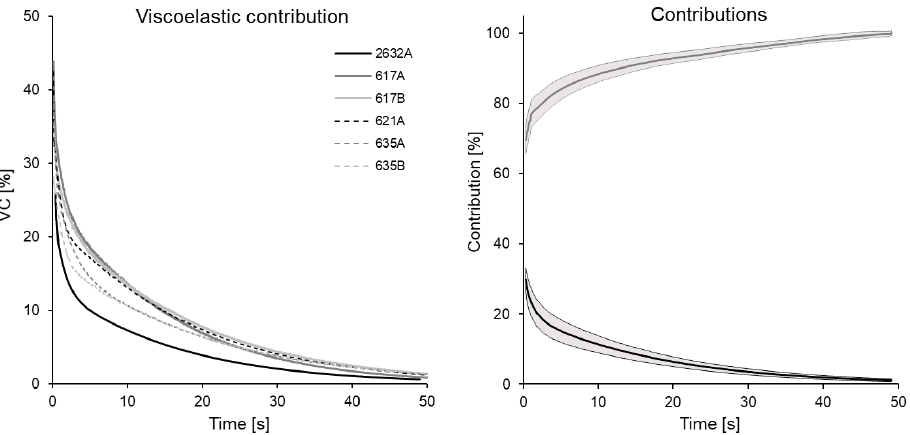
Figure 5. Evolution of VC in strength over time for the analyzed specimens: the black lines indicate the average elastic and viscoelastic contributions as a function of time, the shaded area indicates the error interval in the